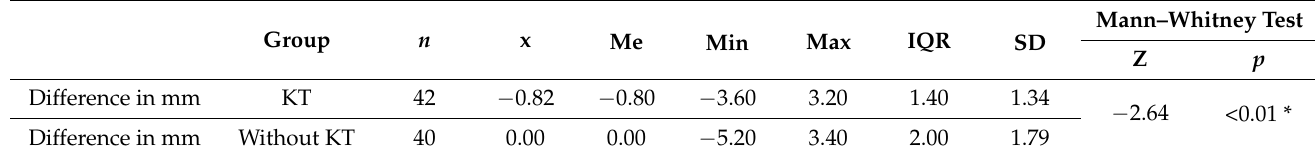
Table 4. Differences [mm] in linear measurement taken 5 cm above fibula neck.